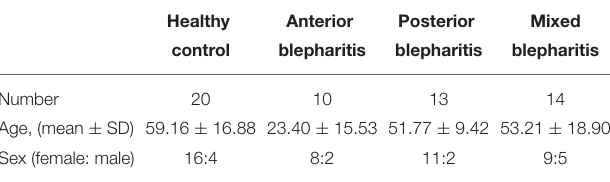
TABLE 1 | Characteristics of the participants in each group. Healthy Anterior Posterior Mixed control blepharitis blepharitis